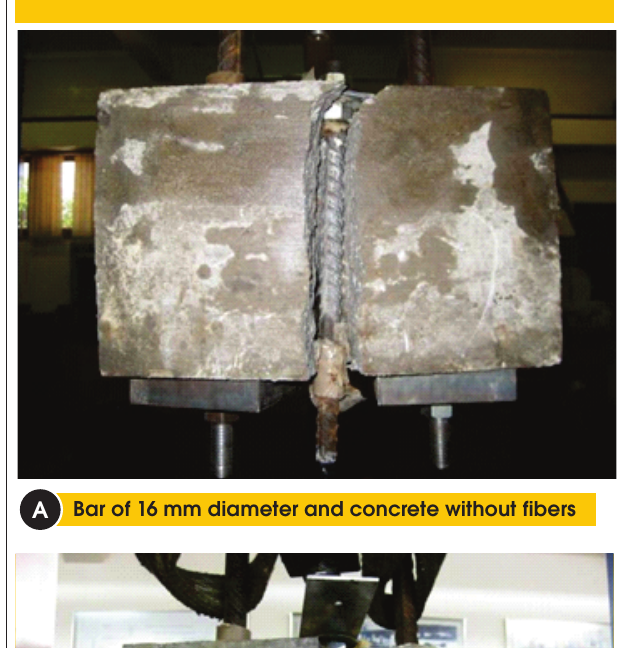
Figure 9 – Load versus bar strain for test specimens with bar of 20 mm